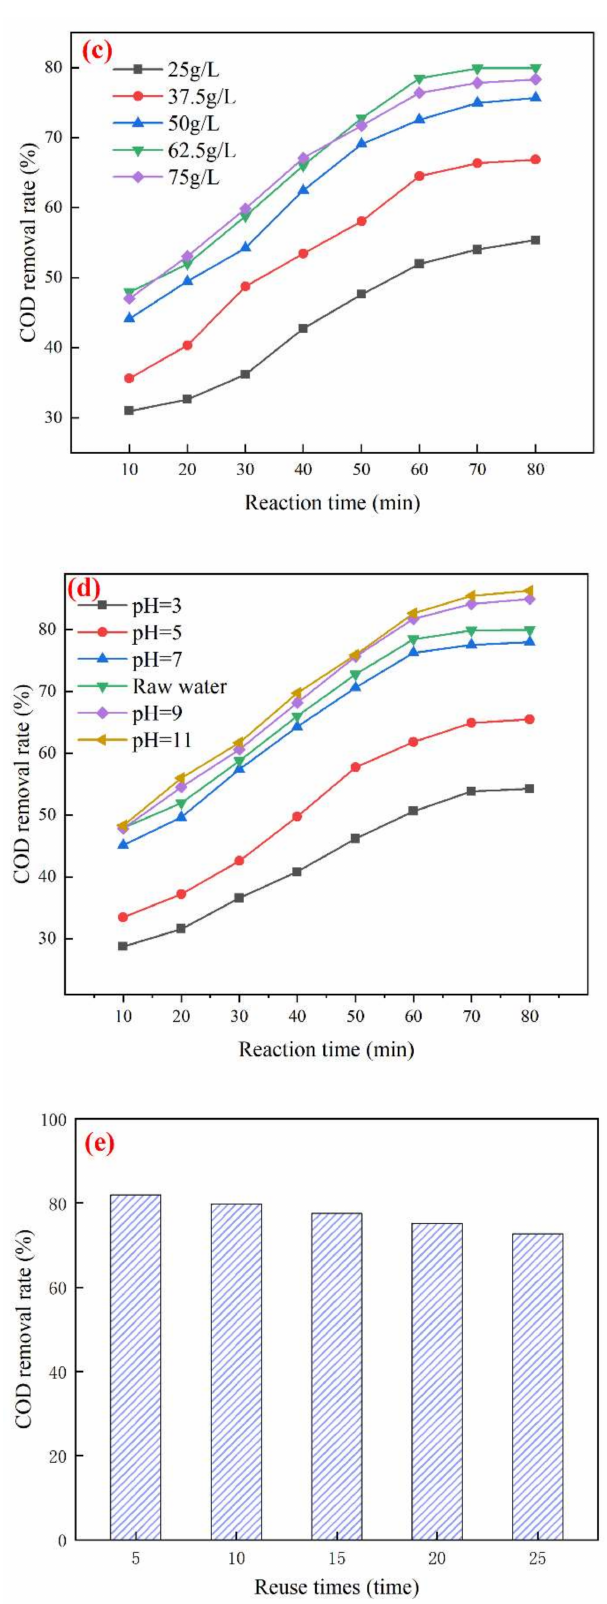
Figure 5. Experimental results of optimum operation in catalytic ozonation and catalyst